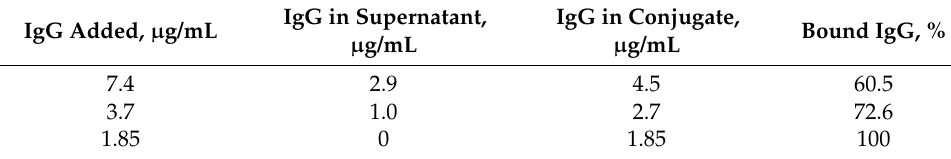
Table 4. Results of the study of the composition of GNP2–IgG conjugates.